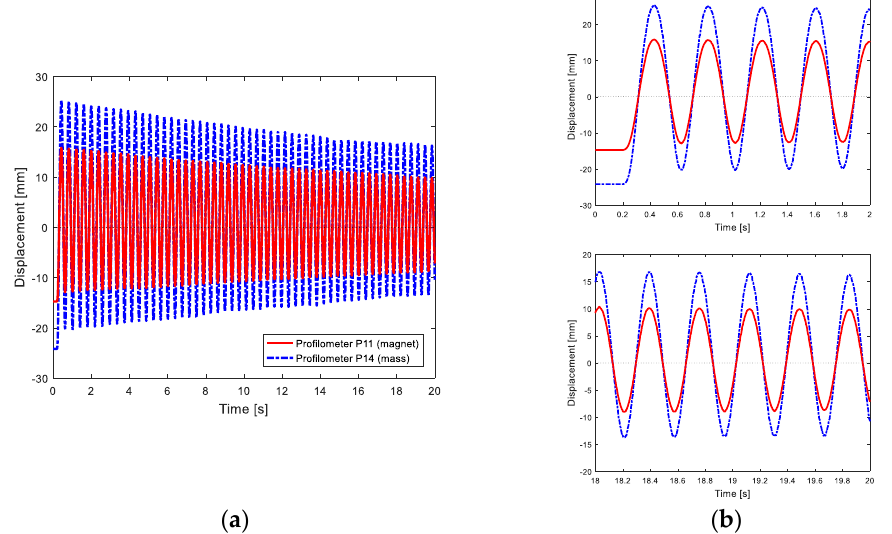
Figure 8. Time history of MaD test using profilometer ( a ), with details at 0 – 2 s and 18 – 20 s ( b ); red line identifies the detected intermedial point, blue line the point detected at the mass.